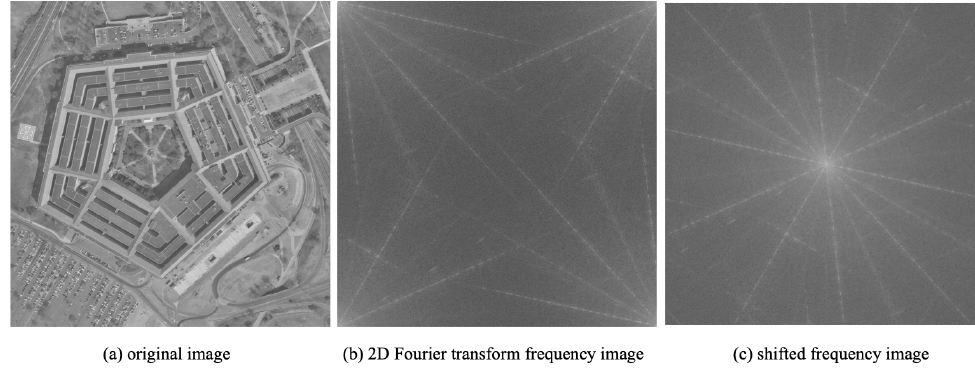
Figure 3. Fourier transform frequency image of image “3.2.25”.